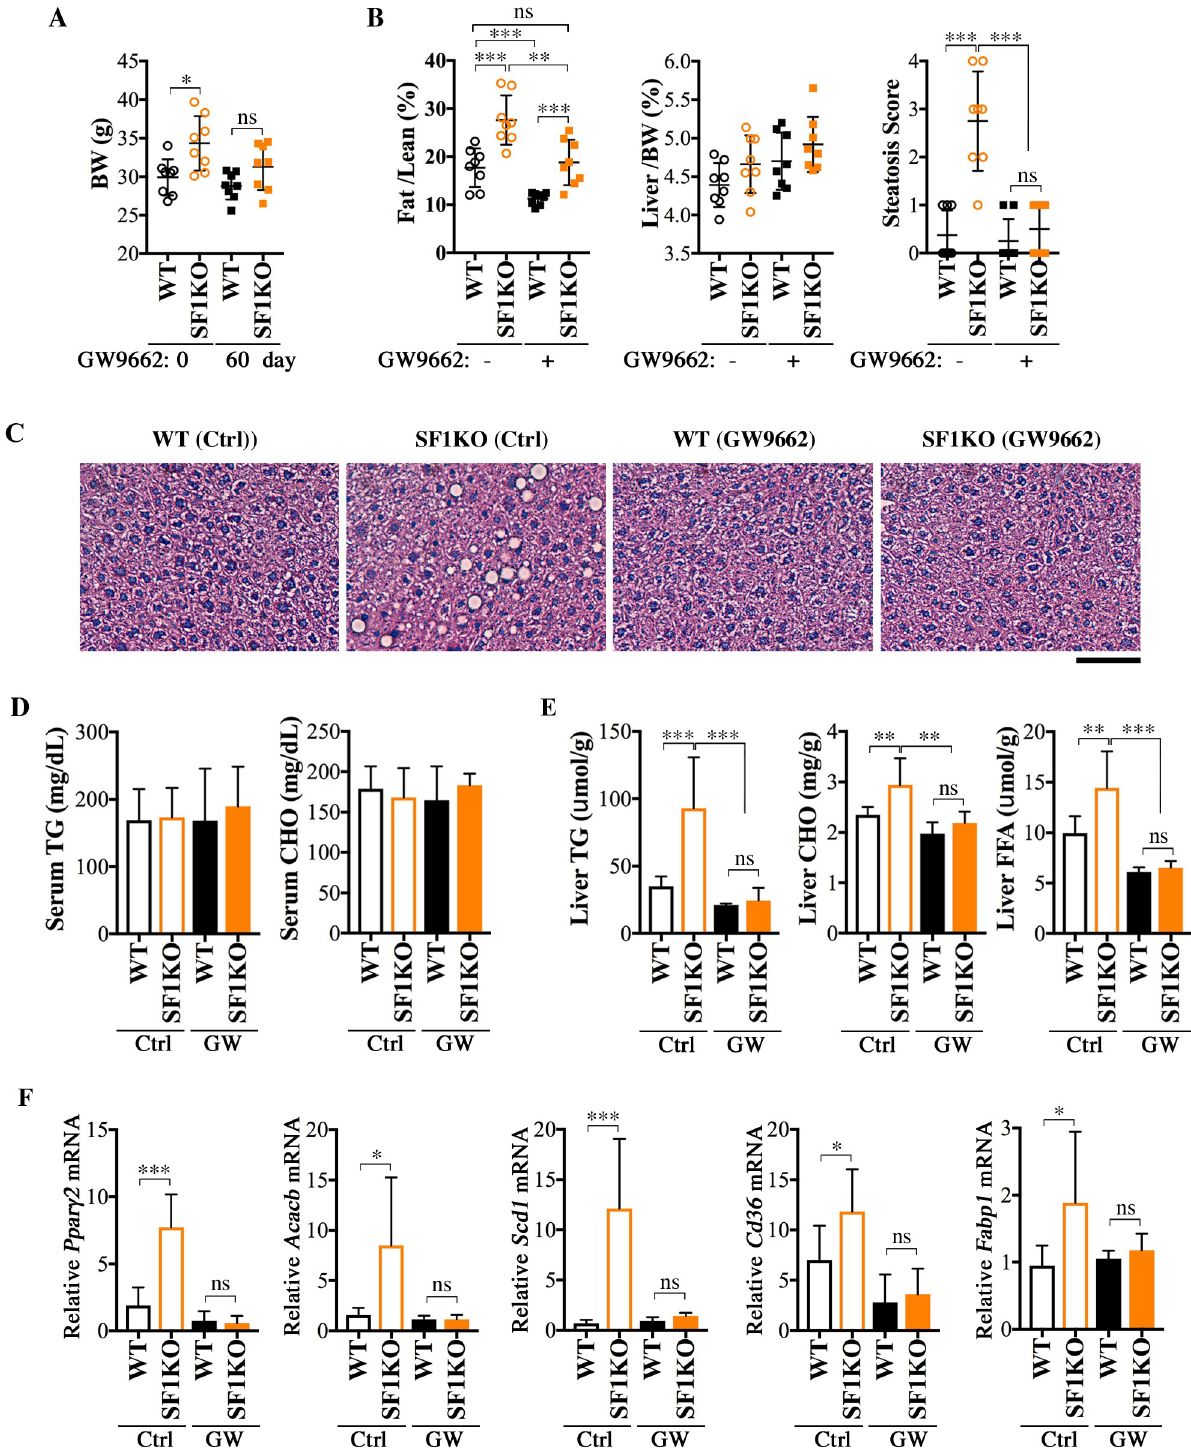
Fig 7. Treatment with PPAR antagonist GW9662 protects BL-Smurf1KO mice from steatosis. (A) BW of male mice from the BL background before (age 7–9 months) and after 60 days (age 9–11 months) of GW9662 treatment ( n = 8 per group). (B) Fat/Lean and Liver/BW ratios and histological score of steatosis of the above mice after GW9662 treatment, compared with those of untreated control mice at the same age ( n = 8 per group). (C) Representative HE-stained sections of the above mice. Bar = 100 μ m. (D) Serum TG and CHO contents of the above mice, n = 8 per group. (E) Liver TG, CHO, and FFA contents of the above GW9662-treated mice. (F) qRT-PCR analysis of expression of Ppar γ 2 and relevant